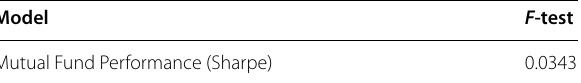
Table 3 Summary of Hausman Test statistical results. Source